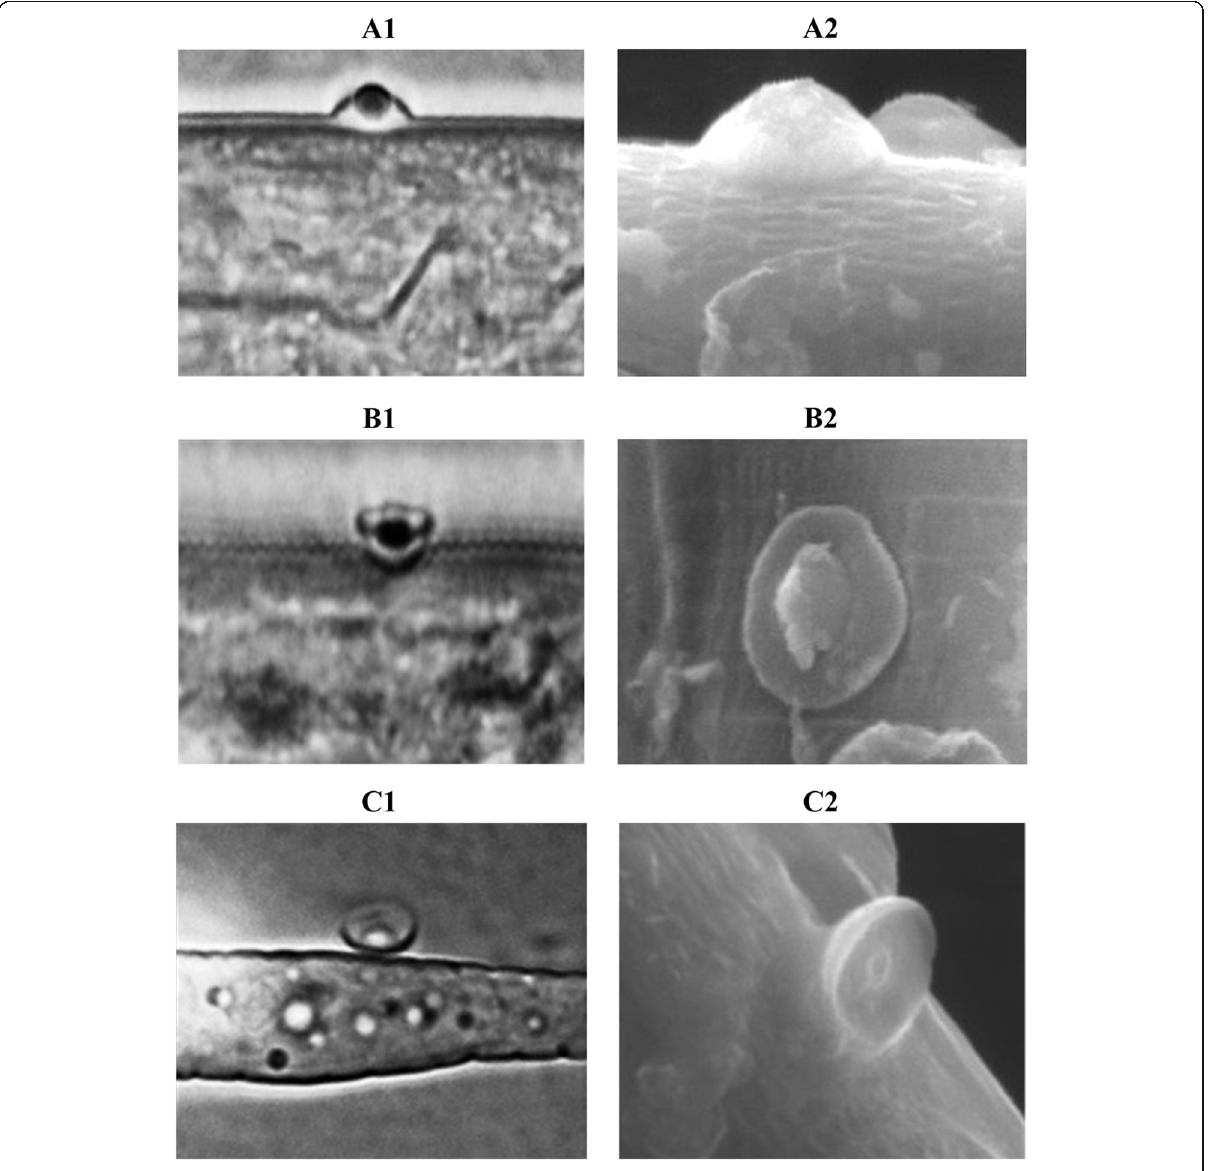
Fig. 3 Types of endospore attachments. Light micrograph ( A1 ) and scanning electron micrograph ( A2 ) of cup-shaped endospore of Pasteuria from Meloidogyne incognita attached in the conventional orientation where concave surface attached to the nematode cuticle, light micrograph ( B1 ) and scanning electron micrograph ( B2 )of an inverted endospore attachment where covex surface attached to the nematode cuticle and light micrograph ( C1 ) and scanning electron micrograph ( C2 ) of the sideways endospore attachment where endospore attached with